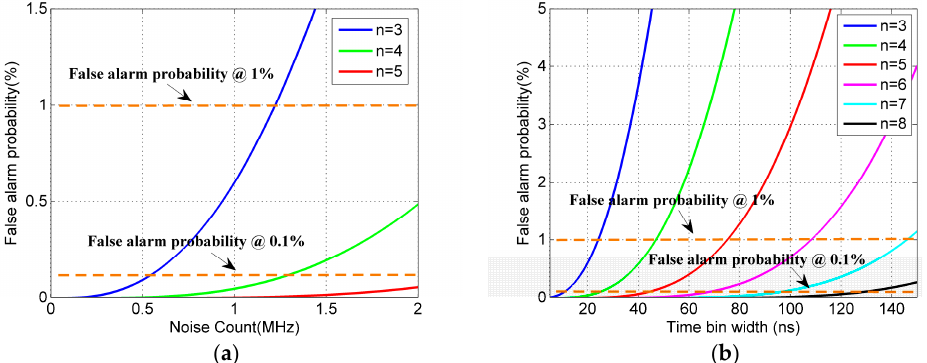
Figure 4. False alarm probability. ( a ) Influence of noise count on false alarm probability ( N = 20, t d = 50 ns, t bin = 20 ns). ( b ) Influence of time bin width on false alarm probability ( N = 20, t d = 50 ns, ψ n = 1 Mcps